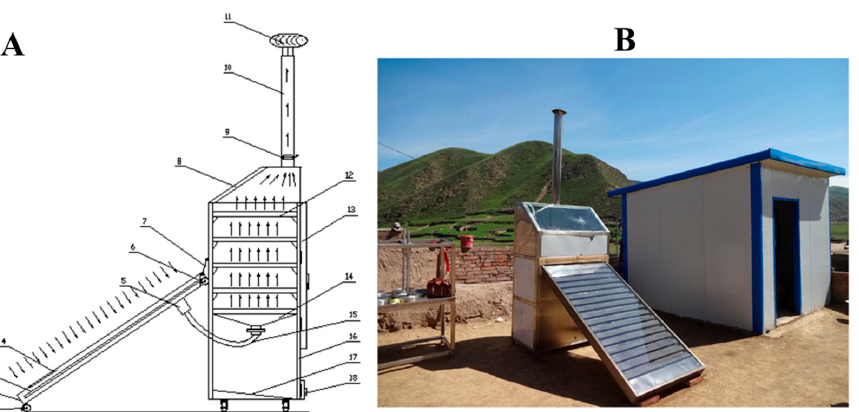
Figure 2. Schematic diagram ( A ) and picture of the facility ( B ) used for Qula solar drying. 1. Caster, 2. solar collector, 3. solar collector tube, 4. air inlet, 5. hot air collection filter, 6. pulley, 7. safety lanyard, 8. transparent window, 9. speed regulation board, 10. chimney, 11. self-rotating vacuum fan, 12.